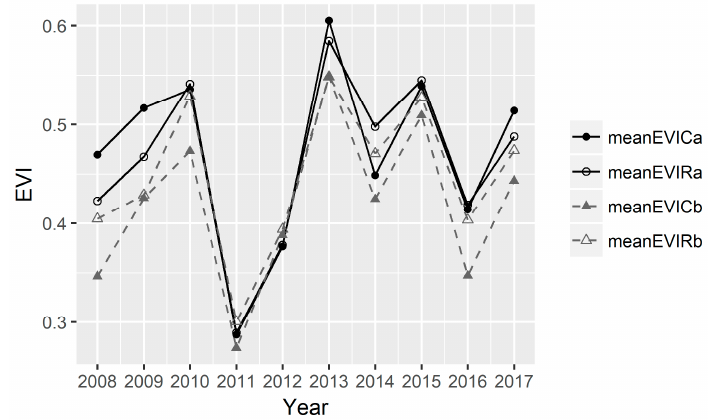
Figure 5. Growing season average EVI from Landsat 7 for different treatments in rep a and rep b. Solid lines are for rep a and dashed lines are for rep b. Solid and hollow shapes represent continuous and rotational grazing.